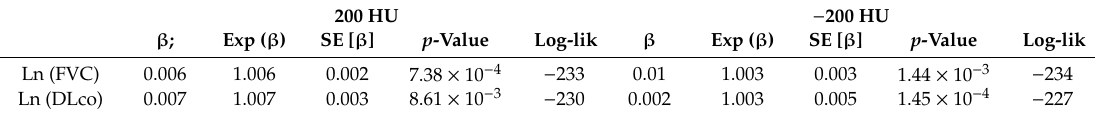
Table 6. Mixed models using FVC and DLco as response variables, and NL at − 200 HU and + 200 HU as the explanatory variable. The regression coe ffi cient estimates ( β ) and their standard error (SE) are reported on the link function scale (natural logarithm -Ln-). For immediate reading, coe ffi cient estimates were exponentiated (Exp). Finally, the comparison was carried out in terms of log-likelihood (Log-lik). 200 HU − 200 HU β